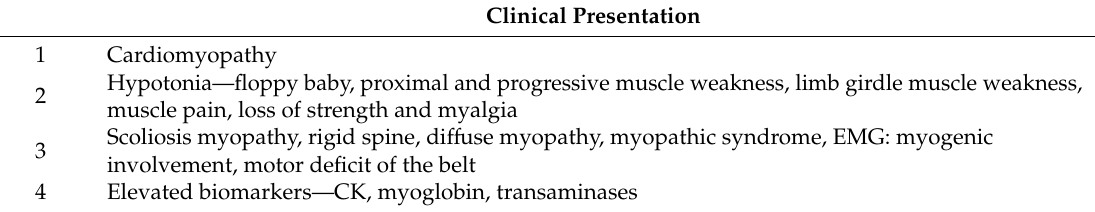
Table 2. Clinical symptoms provided for samples submitted to the study centers in Hamburg and Vienna. Not all specimens contained such information.